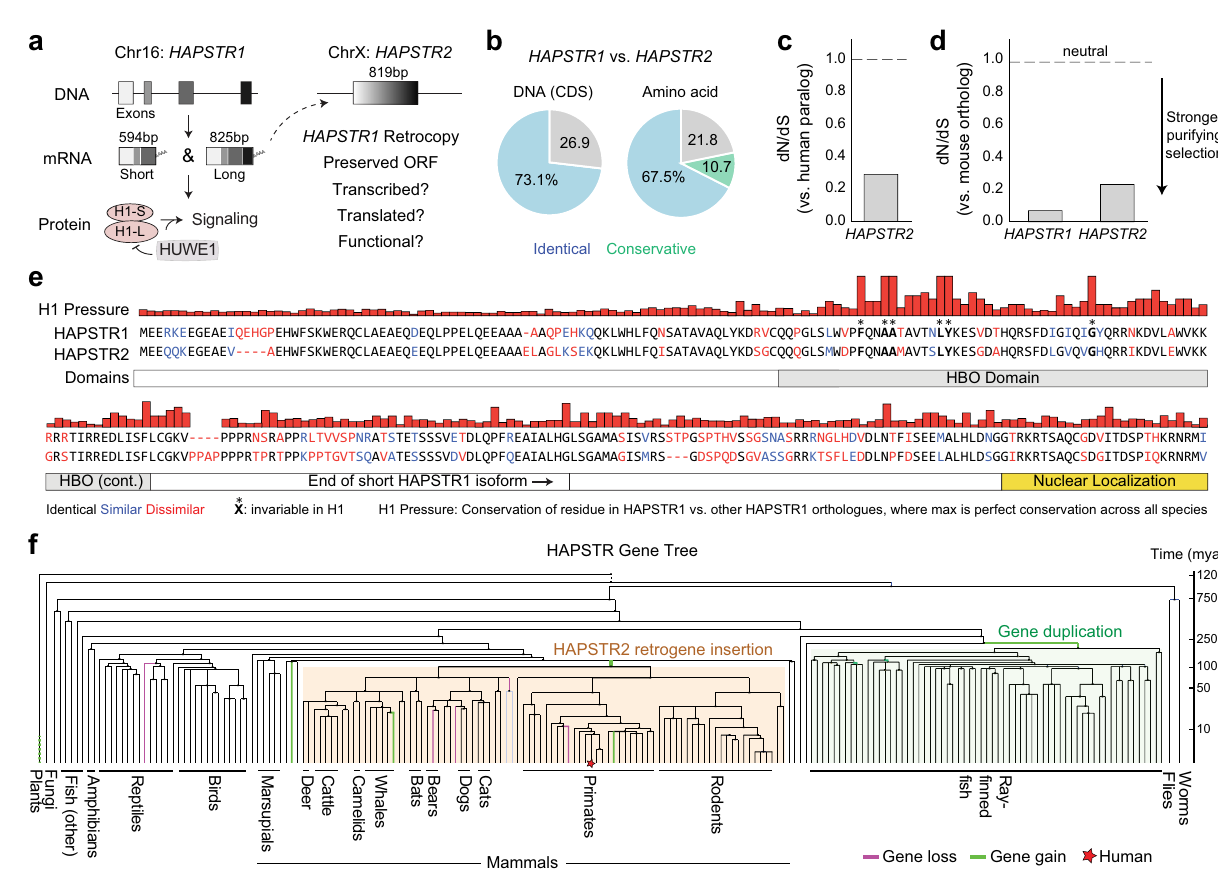
Fig.1|Amammalian HAPSTR2 retrogeneunderpurifyingselection.a Schematic illustrating structure and known function of the HAPSTR1 (H1) gene in comparison with an unstudied retrocopy on the X chromosome. b Sequence identity compar- isons of HAPSTR genes and proteins. CDS, coding sequence. Amino acid substitu- tions were denoted conservative if biochemical features were preserved as determined by the BLOSUM62 matrix. c , d Purifying selection acts on HAPSTR2 as evidenced bycomparison of non-synonymous to synonymous mutation ratio (dN/ dS) in human HAPSTR2 vs. human HAPSTR1 ( c ) or human HAPSTR genes vs. their